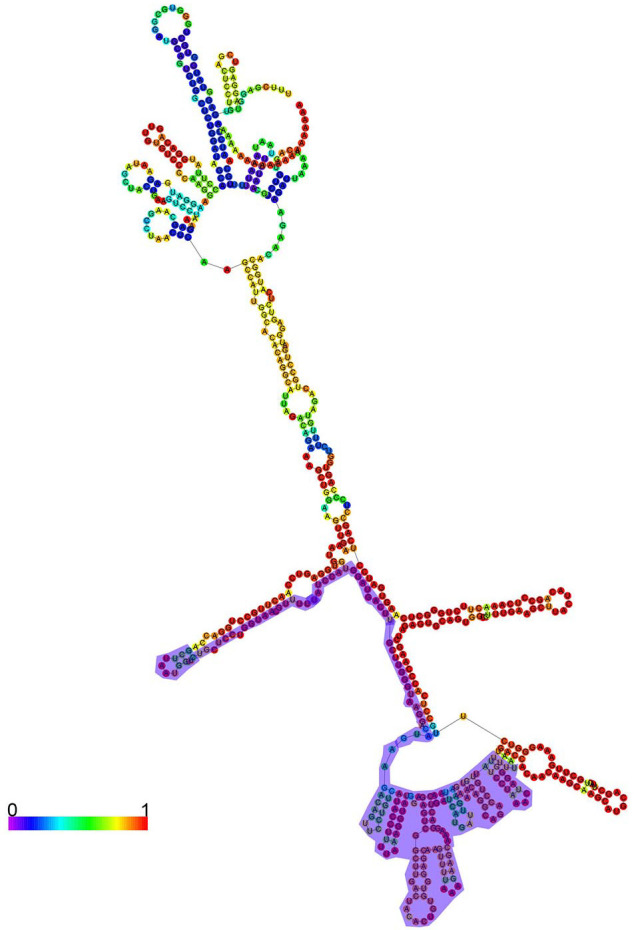
RNA fold model of GAS5.The model was predicted on the RNAfold web server website (http://rna.tbi.univie.ac.at//cgi-bin/RNAWebSuite/RNAfold.cgi). The rainbow color means the base-pair probabilities of the predicted folded RNA. The area of GAS5 combined with UPF1 was painted with lavender.